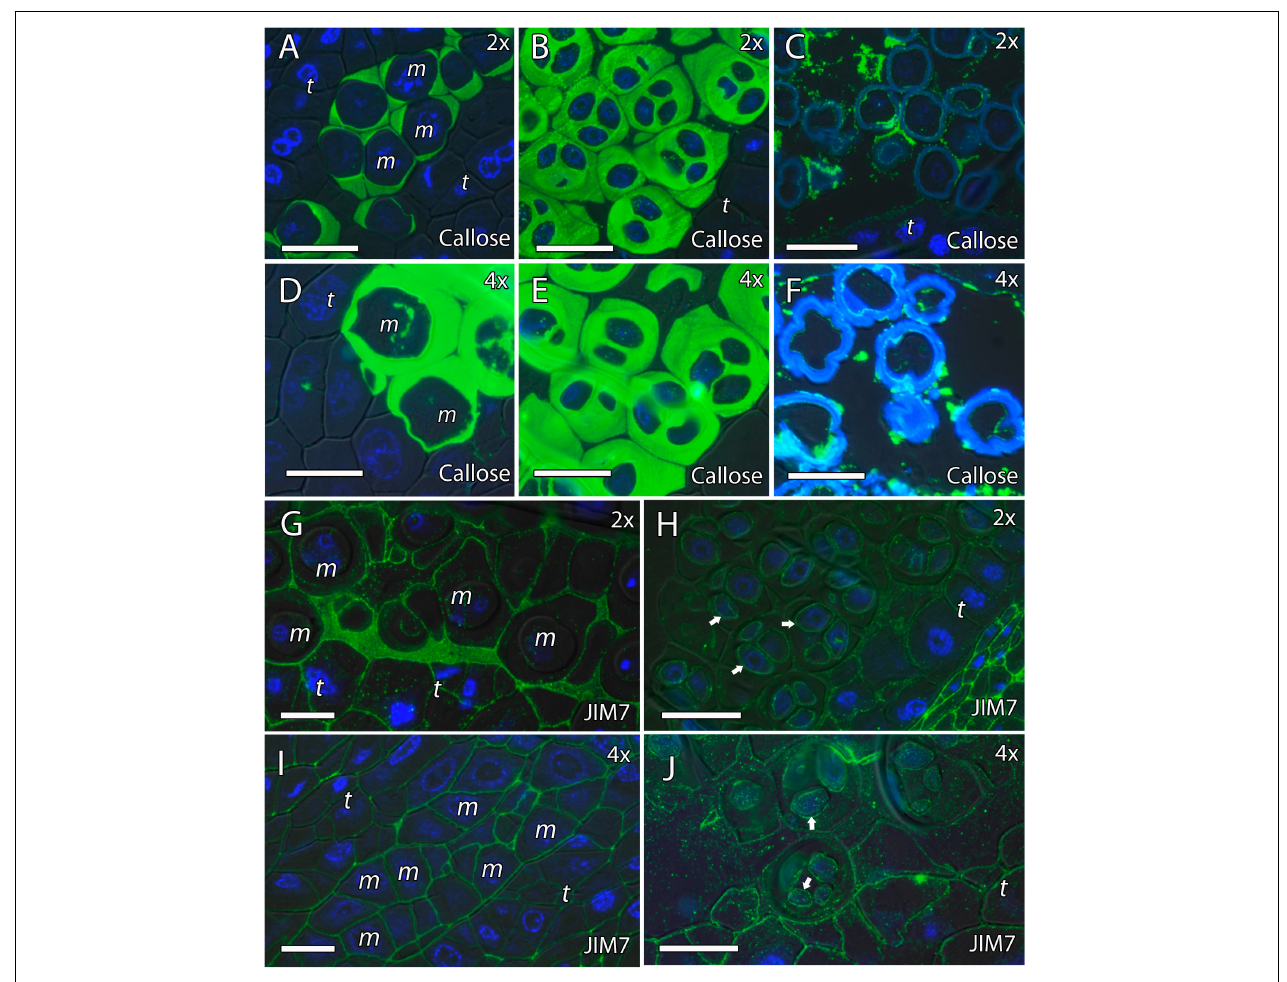
FIGURE 4 | Inmunolocalization of callose and pectins during microsporogenesis in diploid and doubled diploid “Clemenules” clementine. Monoclonal antibodies used: (A–F) anti-callose against callose and (G–J) JIM7 against methyl-esterified pectins. (A–C,G,H) Diploid “Clemenules” and (D–F,I,J) doubled diploid “Clemenules”. (A,D) Anti-callose labeling around MiMCs. (B,E) Anti-callose labeling around the four microspores during simultaneous cytokinesis. (C,F) Callose was still present after microspore tetrad release. (G,I) JIM7 labeling on the MiMC wall. (H,J) JIM7 labeling was still present on the MiMC wall and during early microspore wall formation (arrows). All scale bars = 25 µ m. Tapetum (t), MiMC (m), diploid (2x), and doubled diploid